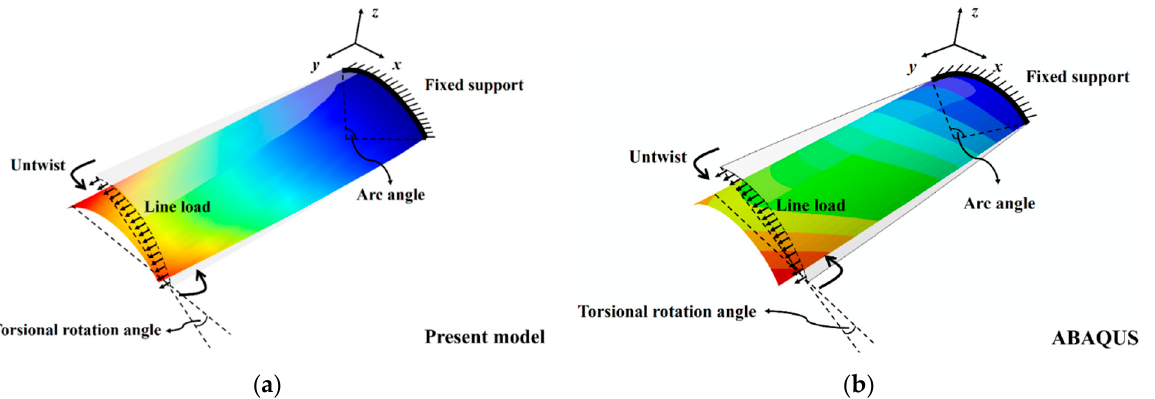
14 of 22 Figure 8. Geometries of a pre-twisted cantilever with arc profile cross section and remarkable dif- ference in discretization between the present model and ABAQUS model: ( a ) 3D geometries from CAD in ( e x , e y , e z ), ( b ) 1 L9 element for cross-sectional discretization and 10 B2 elements for axial discretization based on current formulations in ( e ξ , e y , e η ), and ( c ) converged 1008 shell elements from ABAQUS in ( e x , e y , e z ). Figure 9 provides the 3D structural configurations of a 30° pre-twisted cantilever